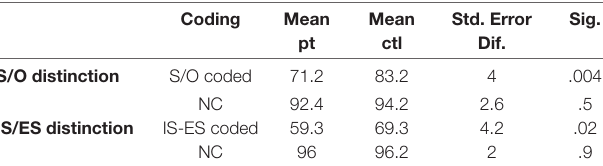
The mean of percent of accurate responses in patients (pt) was significantly lower from that of controls (ctl) for agency and spatially coded sentences (bold font) but not for sentences that were not agency or spatially